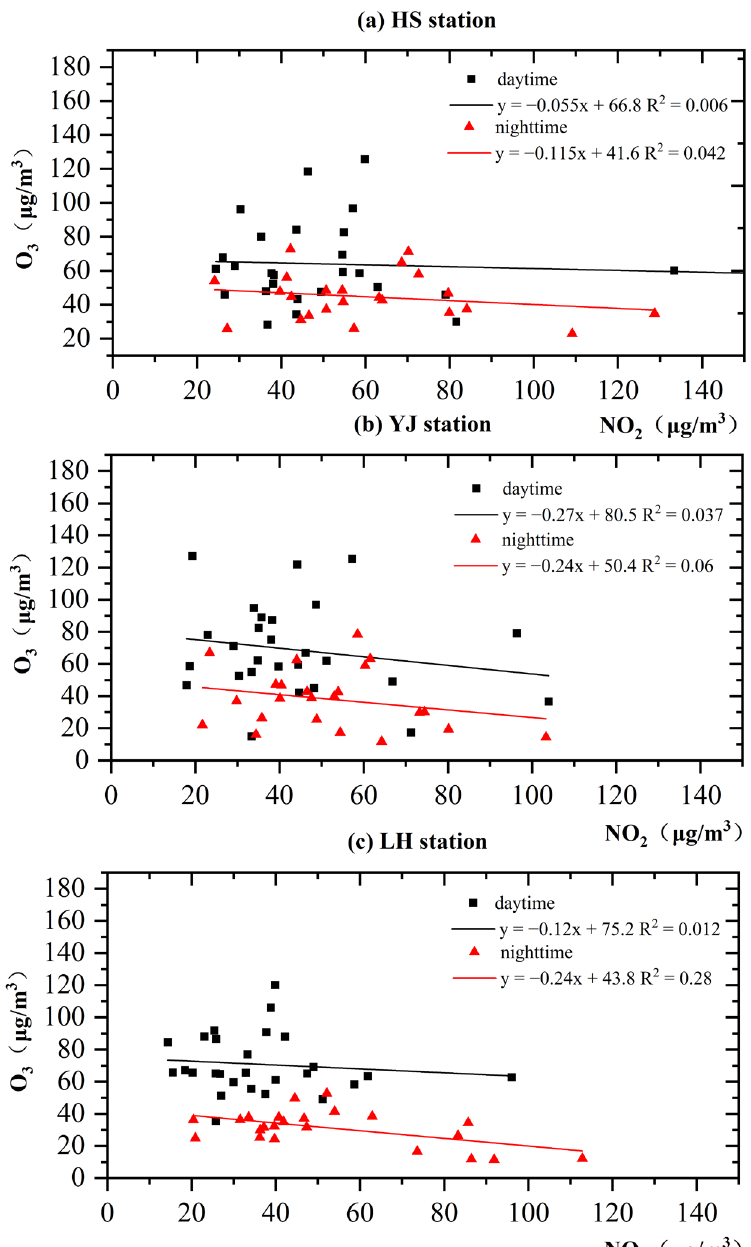
Figure 4. Scatterplot of O 3 and NO 2 concentrations at HS ( a ), YJ ( b ), and LH ( c ).